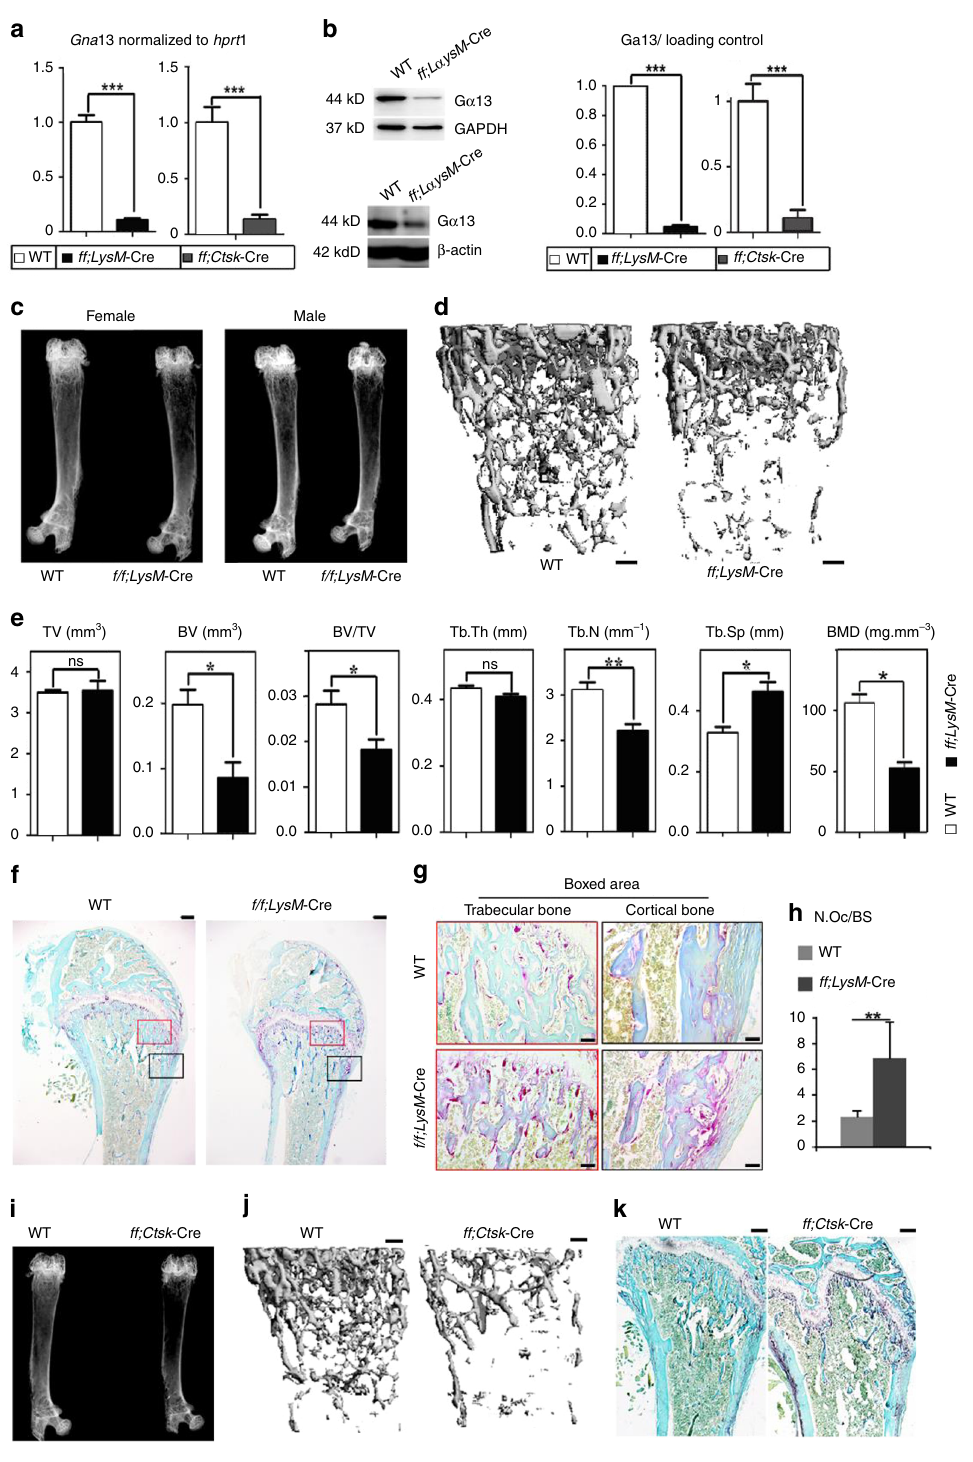
Fig. 1 Osteoclast-speci fi c Gna13-CKO mice displayed